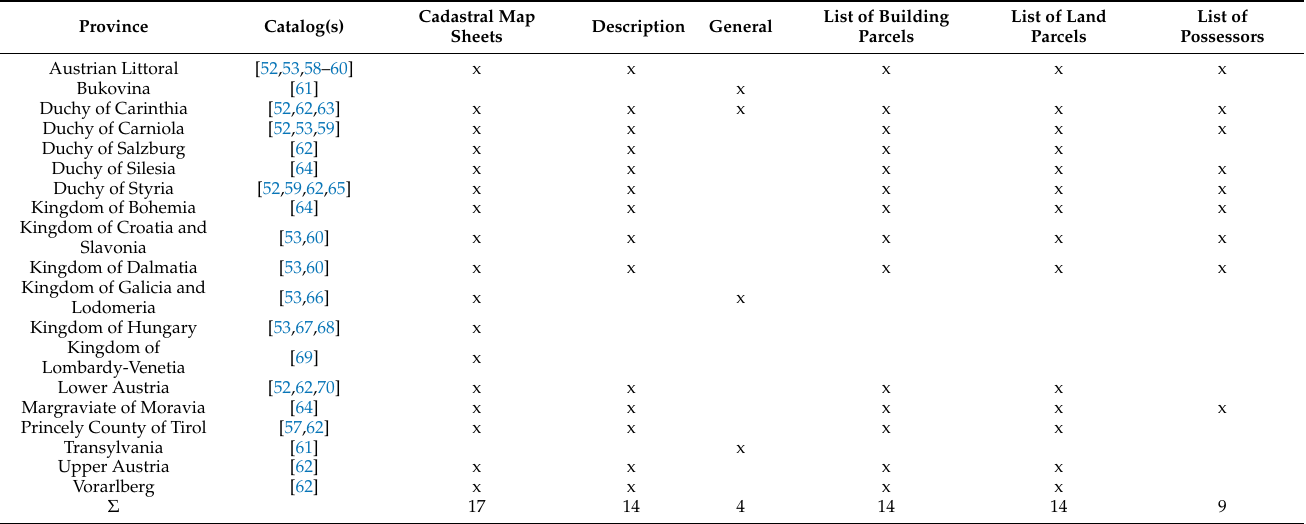
Table 1. Availability of documents for provinces in the Franciscan Cadastre through the discovery service. Province